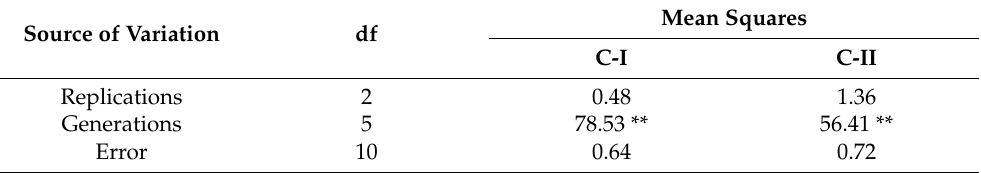
Table 3. Analysis of variance (ANOVA) for lesion length (cm) development in two populations of Indian mustard.